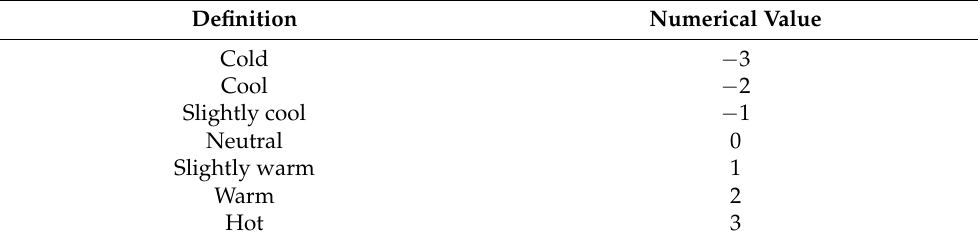
Table 3. Thermal sensation evaluation index.